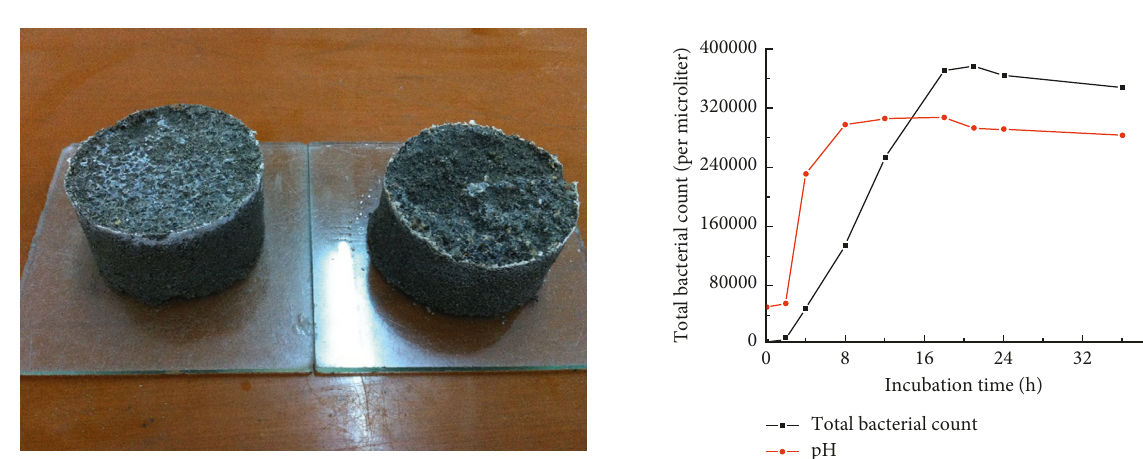
Figure 8: Changes in bacterial density and pH value in mixed media as function of time.